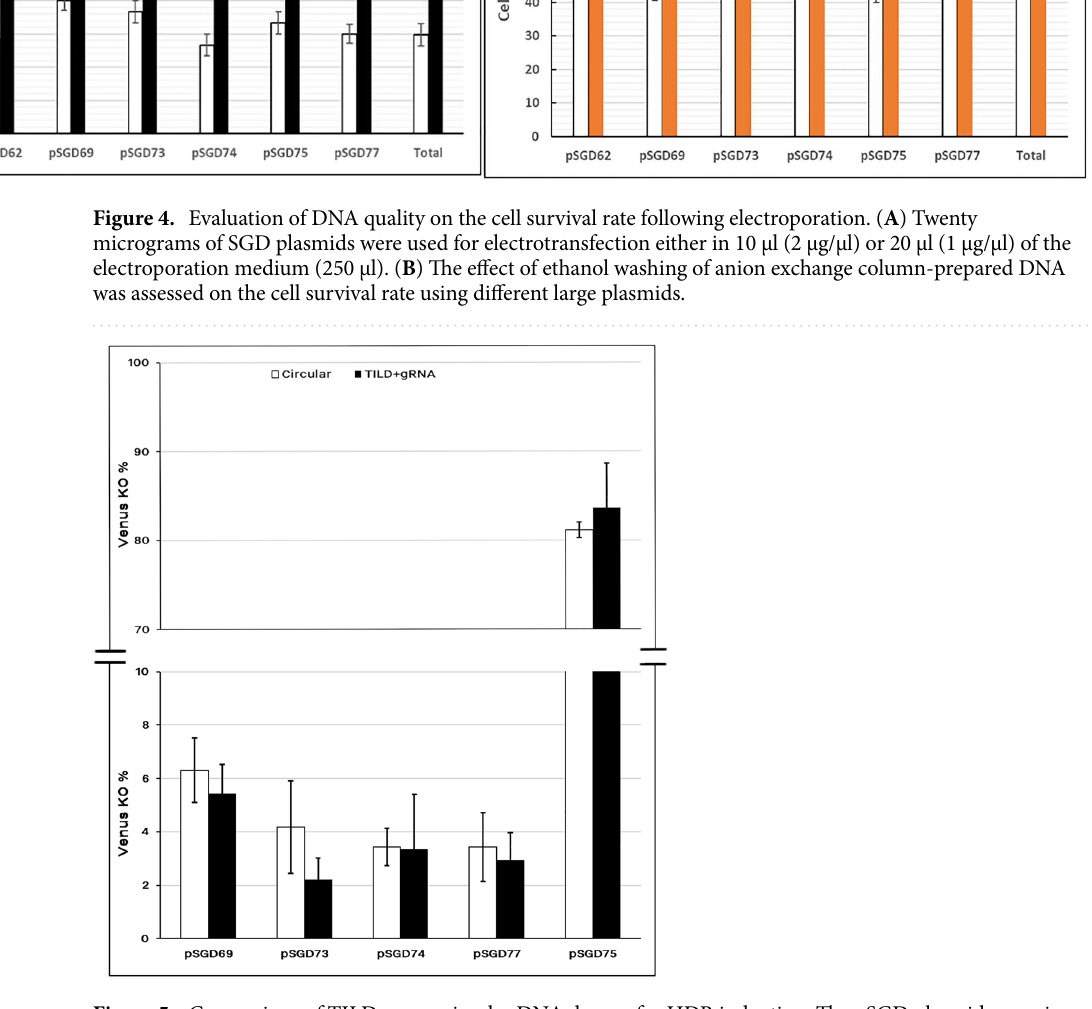
against puromycin, cells were cultured with no antibiotic selection for an 8-day period. Then, a fraction of cells was analyzed for Venus fluorescence using FACS analysis. Using the pSGD69 plasmid, inclusion of 0–40 ng/ µl nocodazole into the electroporation medium did not significantly improved the HDR rate (p-value > 0.05). However, inclusion of 70 ng/µl nocodazole into the electroporation medium could considerably improve the Venus knock-out rate (21%) compared to both control and sham groups (3% DMSO) (p-value < 0.05). Then, all five plasmids were co-electroporated with 70 ng/µl nocodazole into the MEF cells. FACS results of Venus knock- out rate at 10 days after the electroporation reproduced high rate of Venus knock-out using pSGD69, expressing gRNA-69, and pSGD73, 74, and 77 expressing gRNA-72 (21–26%). Electroporation of the pSGD75, expressing both gRNA-72 and gRNA + 121, caused 95% Venus knock-out.